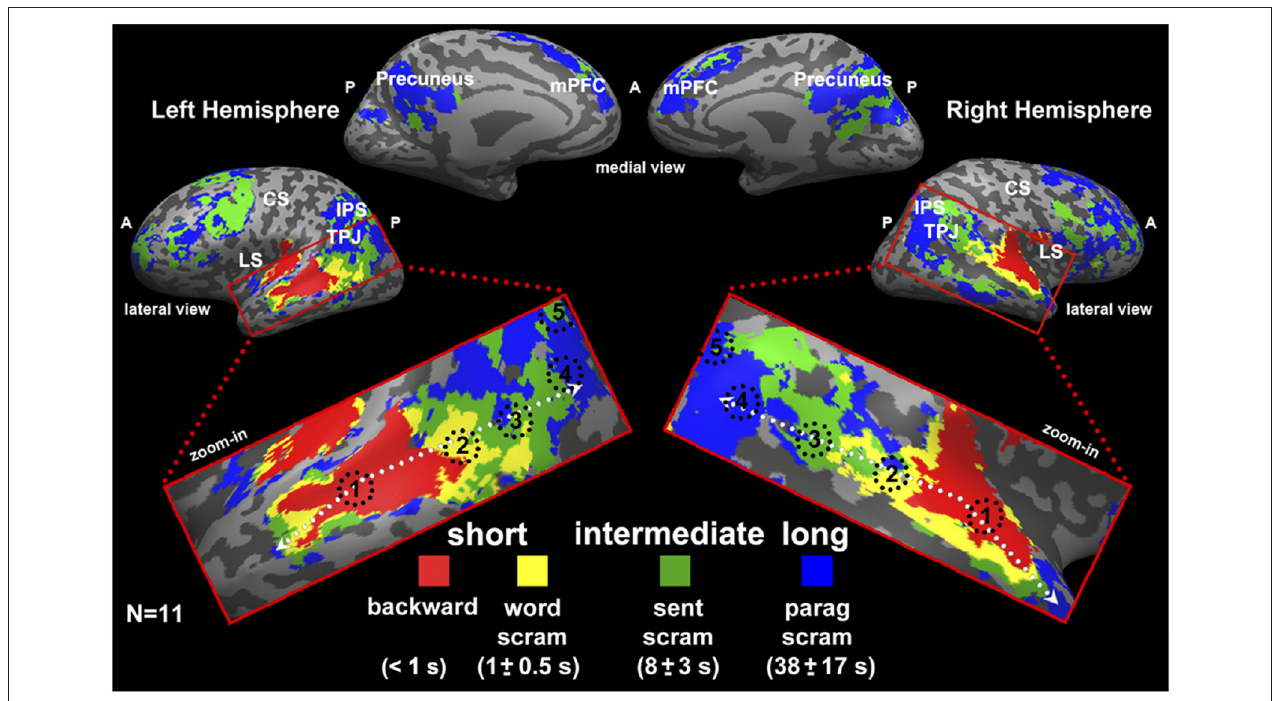
FIGURE 7 | Study by Lerner et al. (2011) as an example for representations in a hierarchy of time scales. Here, the authors used fMRI and a between-subject correlational analysis to categorize brain voxels according to four levels of representation. These four levels were fast dynamics of auditory input (red), words (yellow), sentences (green), and paragraphs (blue). Results are displayed on a so-called inflated cortical surface. Figure reprinted from Lerner et al.